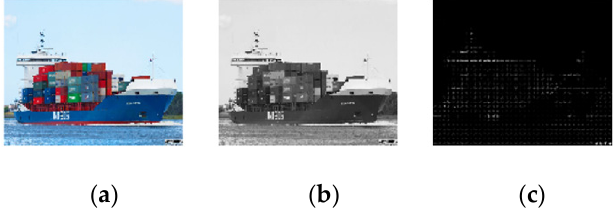
Figure 7. Illustration of HOG feature using the self-built dataset : ( a ) Original image; ( b ) grayscale image; and ( c ) HOG feature.